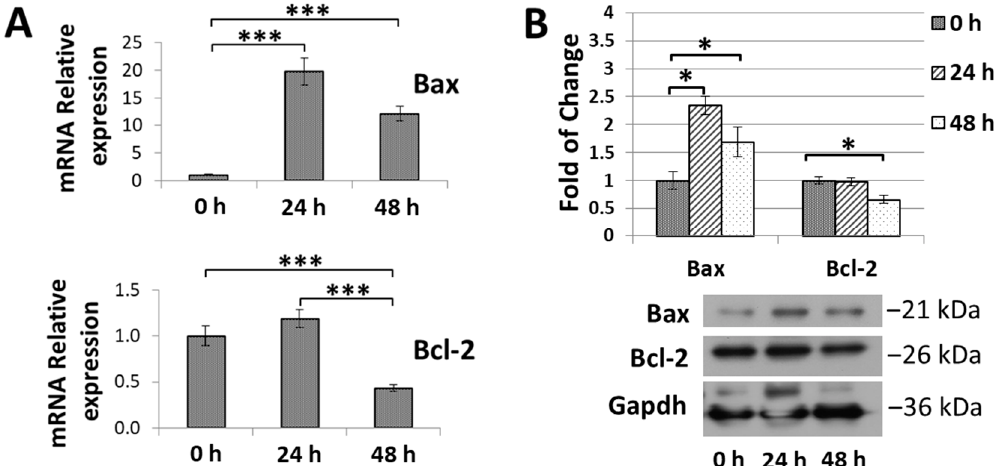
Figure 5. The expression of bax and bcl-2 gene. ( A ) The transcript expression of bax and bcl-2 was performed by real-time RT-PCR, *** indicates significant difference between groups ( p < 0.001). ( B ) Western blot was applied to estimate the expression of bax and bcl-2. * indicates significant dif-